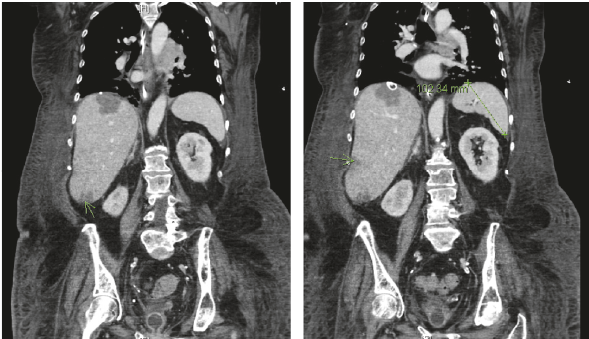
Figure 2: Cross sections of computed tomography of the torso showing scattered, ill-defined, hypoattenuating lesions (green arrows) in the right hepatic lobes of an enlarged liver. Spleen is found to be normal in size, measuring 10.2 cm in